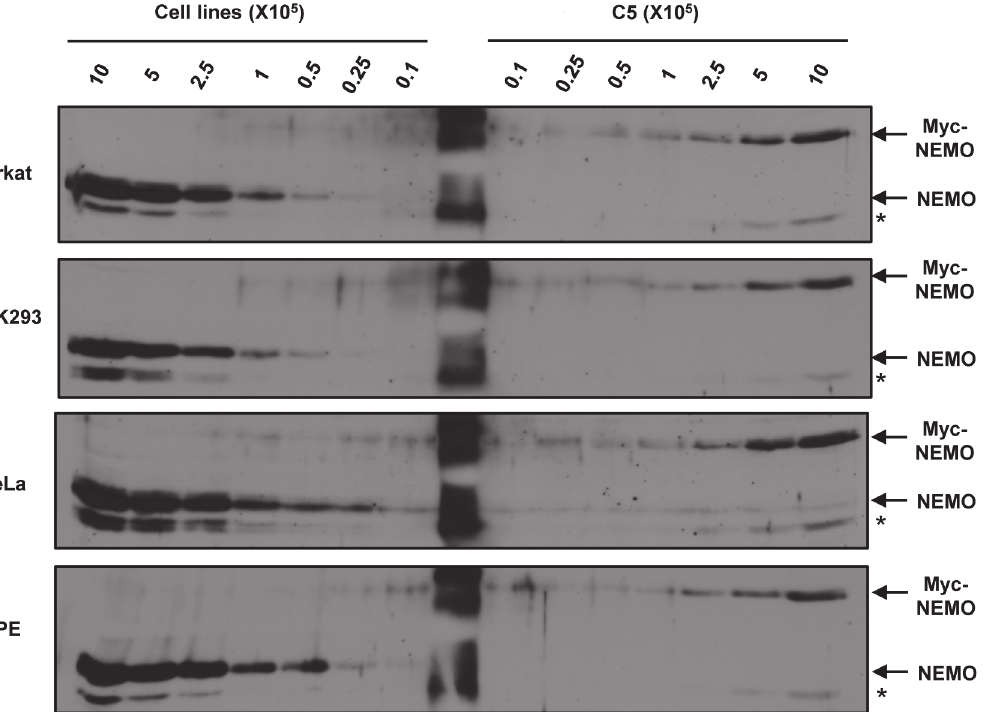
Fig 6. Determination of the average number of NEMO molecules in multiple human cell lines. Representative NEMO Western blots of protein extracts from the indicated number of Jurkat, HEK293, HeLa, and RPE cells compared to protein extracts from the indicated number of C5 cells are shown. * represents non-specific band. Each blot was performed three biological replicates except for HEK293 which was two biological replicates.